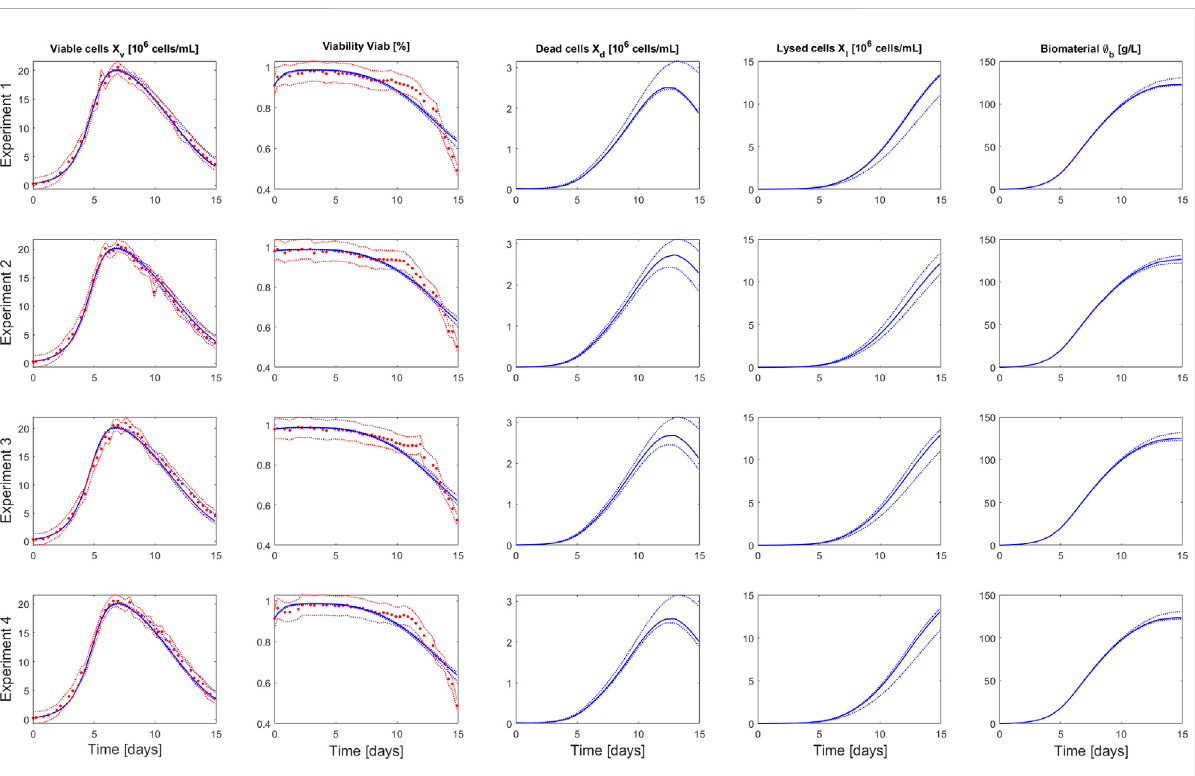
FIGURE 2 Comparison between measurements of Ambr ® 250 fed-batch experiments 1 – 4 (red dots) and the model simulation (blue curve) performed using the parameters value identi fi ed on the whole set of experiments. The dashed red lines represent the experimental con fi dence interval. The dashed blue lines represent the uncertainty in the model predictions — calculated using Monte Carlo simulations (1000 samples) of normally distributed pseudo random parameters values (parameter space de fi ned by θ ± 2 σ θ